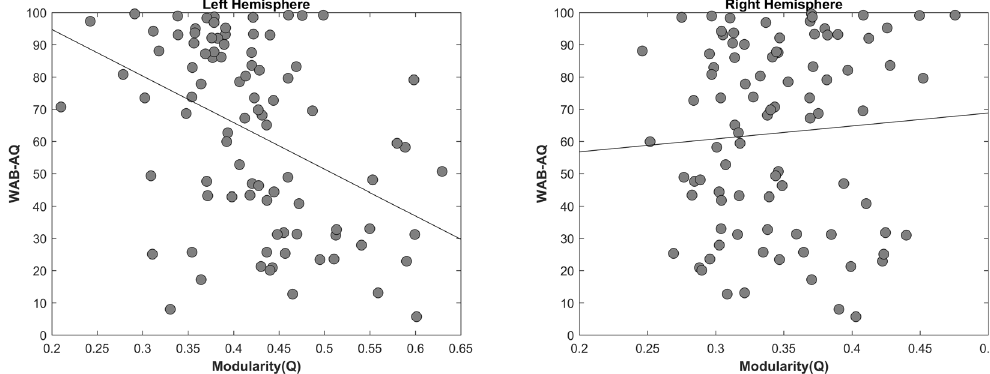
Figure 1. Correlation between modularity and aphasia severity in the left hemisphere (r = − 0.4215, p < 0.00001), right hemisphere (r = 0.0698, p = 0.5135).